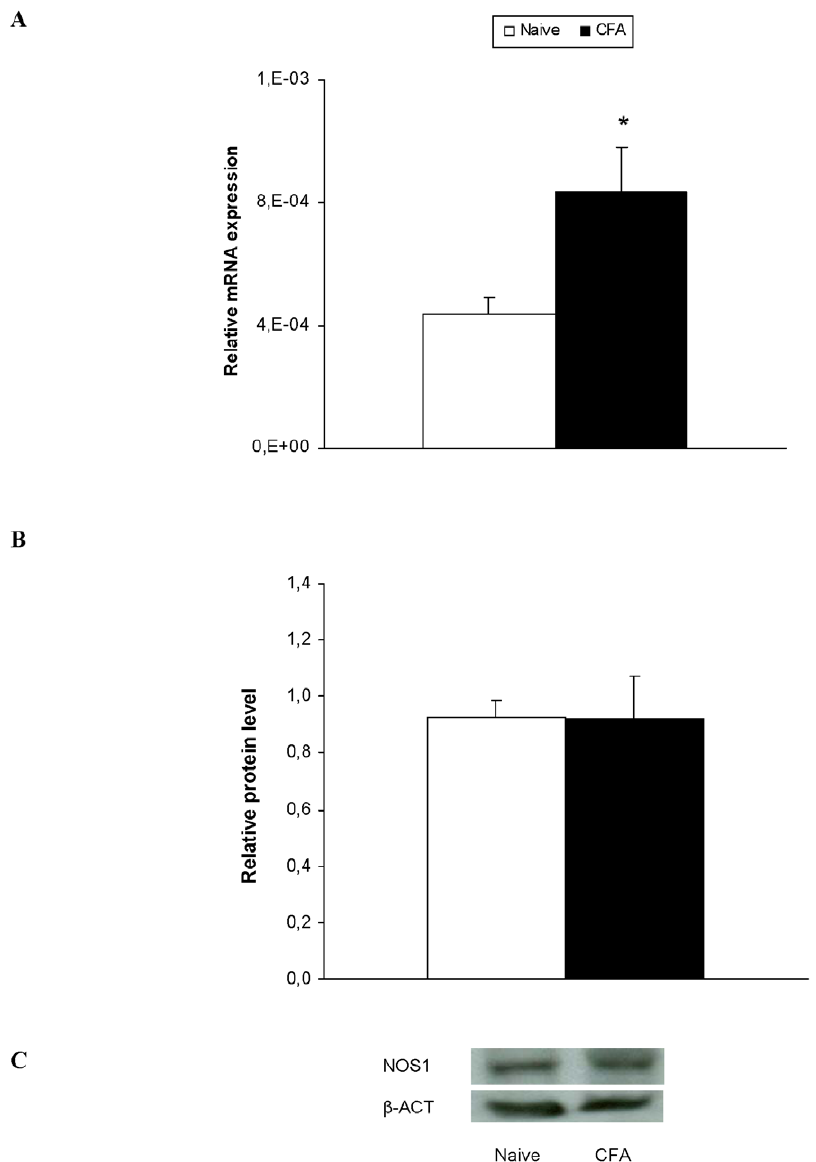
Figure 4. Dorsal root ganglia expression of NOS1. The relative mRNA (A) and protein (B) expression of NOS1 in the ipsilateral side of the dorsal root ganglia from naive and CFA injected WT mice are represented. A representative example of Western blot for NOS1 protein (155 kDa) in which b - actin (43 kDa) was used as a loading control is shown in C. Data are expressed as the mean values 6 SEM of 5–6 samples per group. * indicates significant differences when compared CFA vs. naı¨ve mice (p , 0.05, Student’s t